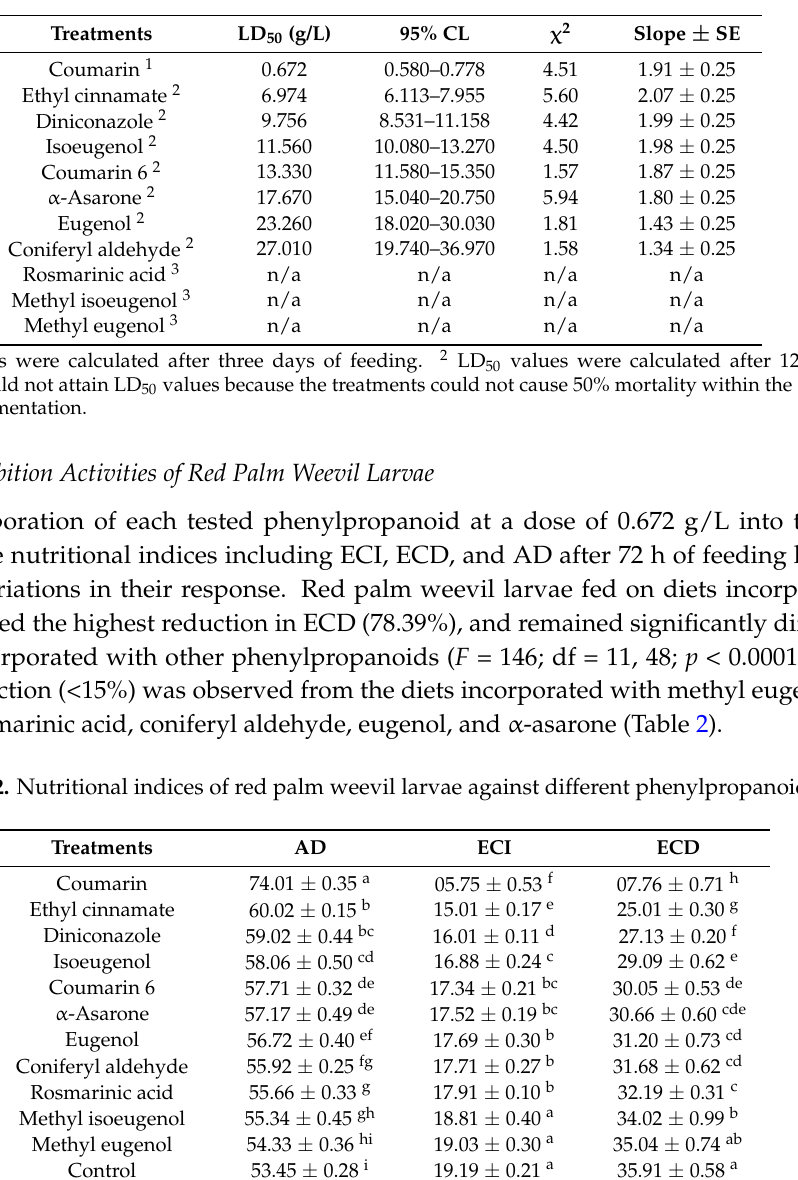
Table 1. Dose mortality response of red palm weevil larvae against different phenylpropanoids.